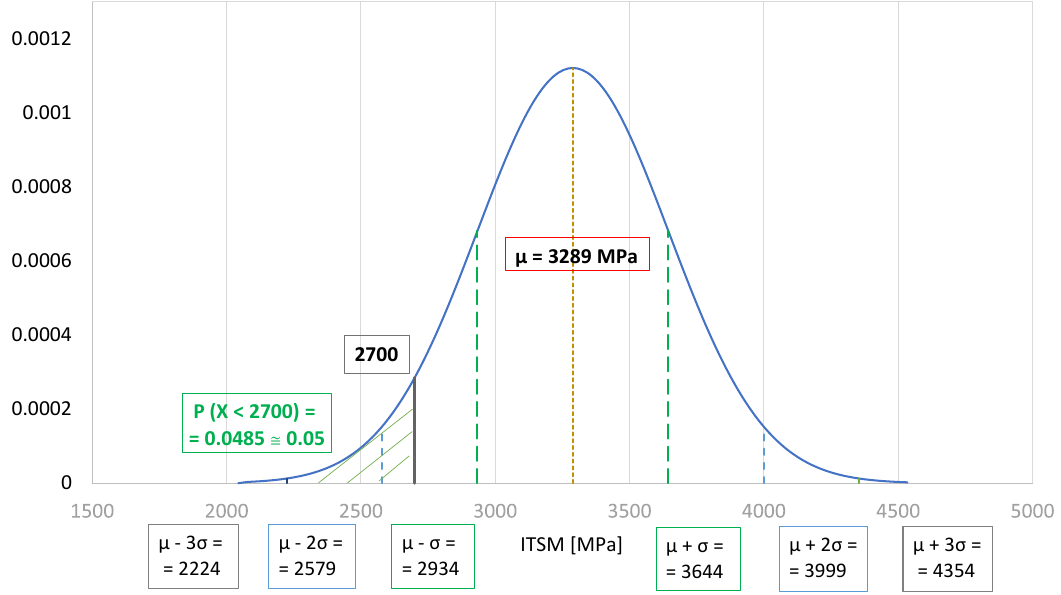
Figure 7. Probability density function of a normal distribution N (3289; 355) for ITSM values at 13 °C.